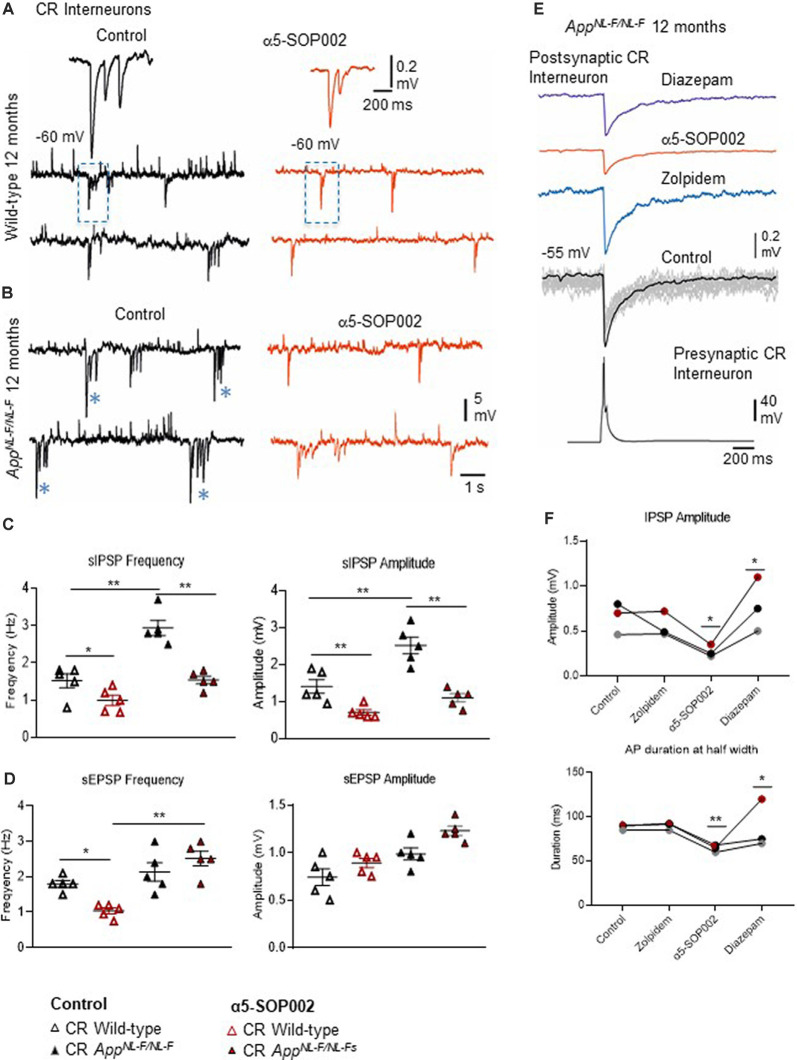
Calretinin (CR)-expressing interneurons are functionally restored by NAM of α5 subunit-containing GABAARs in APPNL−F/NL−F mice. (A,B) Whole-cell current-clamp recordings of spontaneous inhibitory/excitatory postsynaptic potentials (sIPSPs and sEPSPs) recorded in CR cells in CA1 of 12-month-old wild-type and APPNL−F/NL−F mice, at membrane potentials of −60 mV in control conditions, and after bath-application of α5-SOP002 (red traces). The squares indicate where synaptic events have been enlarged and shown in the inserts. *Indicate, an usually high sIPSPs recorded in the AD model. (C,D) Bar graphs show the average sIPSP and sEPSP amplitude and frequency at −60 mV in CR cells recorded in wild-type mice and the APPNL−F/NL−F mouse model. These data suggest a significantly enhanced amplitude and frequency of inhibition in the AD model, which was “normalized” to control values after bath- application of α5-SOP002. **P < 0.01, Data analyzed with a two-way ANOVA and post hoc Tukey’s test. (E) Paired recording obtained between two putative CR cells recorded in SR of CA1 in the AD model. The unitary IPSPs were not sensitive to zolpidem, reduced by α5-SOP002, and then enhanced by subsequent addition of diazepam, indicating α5 pharmacology. (F) Line graphs show the average unitary IPSP amplitude and width at half amplitude change for each paired recording between two CR cells, in control, and after bath-application of zolpidem, α5-SOP002 and diazepam, recorded at −55 mV in APPNL−F/NL−F mouse model. *P < 0.05, **P < 0.01. Data analyzed with a one-way ANOVA and post hoc Tukey test. Blue (*) are representative traces that have been enlarged in the inserts.